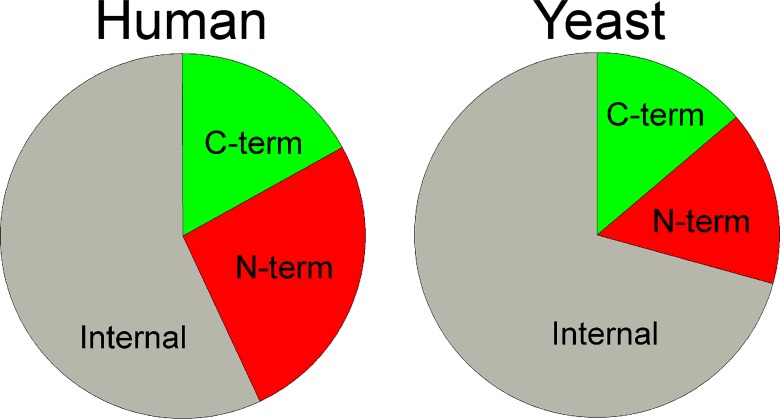
Location of peptides within proteins.C-term refers to peptides that contain the C-terminal residue of the protein. N-term includes peptides with the N-terminal initiation Met as well as peptides with this Met removed (including acetylated peptides). A small number of proteins are known to contain precursor sequences that are cleaved to produce the mature form of the protein, and several of the human N-terminal peptides correspond to the N-terminus of the mature form. See S1 and S3 Tables for peptide sequences.